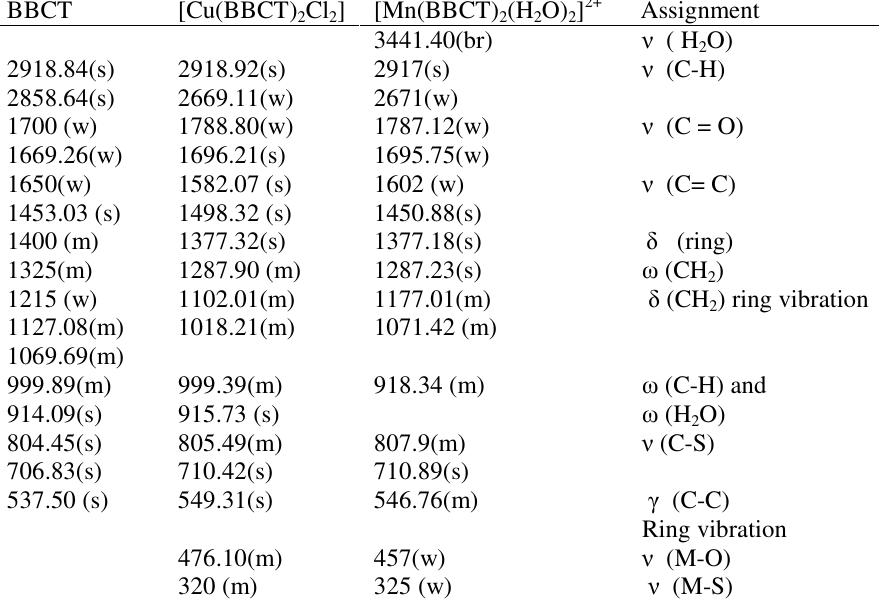
Table 5. IR spectral data (cm -1 ) of BBCT and its Cu(II) and Mn(II)